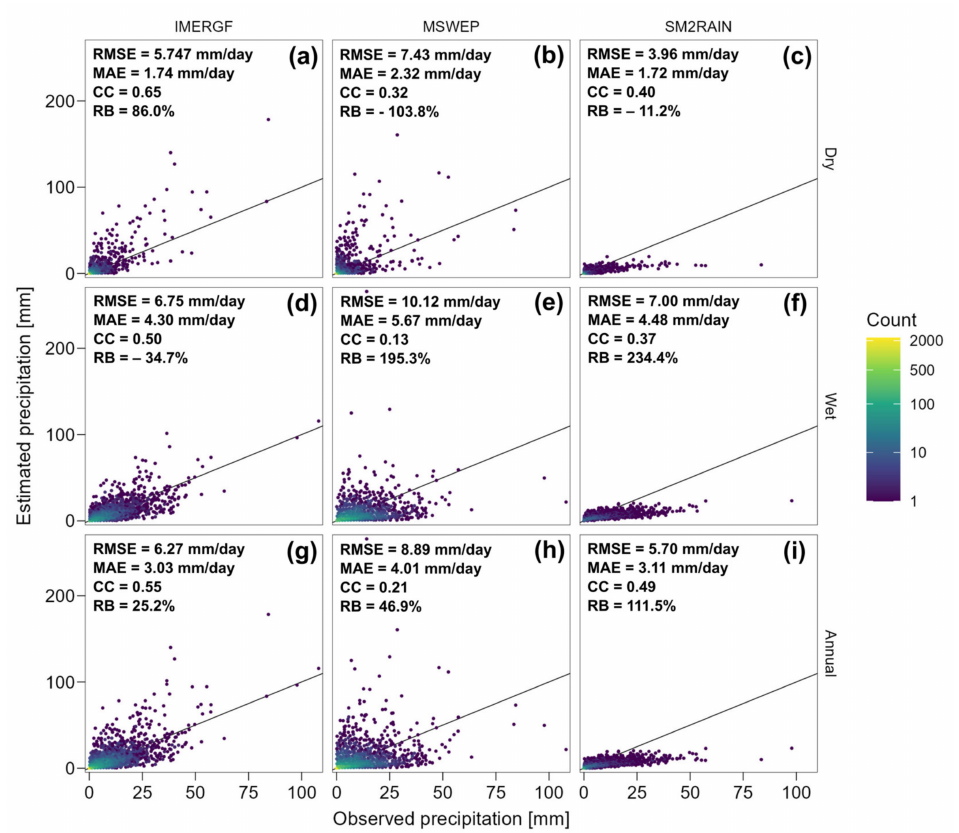
Figure 5. Density-colored scatter plots for ( a – c ) dry, ( d – f ) wet, and ( g – i ) annual rainfall between the estimated precipitation from SPPs and the observed precipitation from rain gauges. The black line is the 1:1 line. Each statistical metric is also shown in the figure, and the colors in this figure represent the frequency of